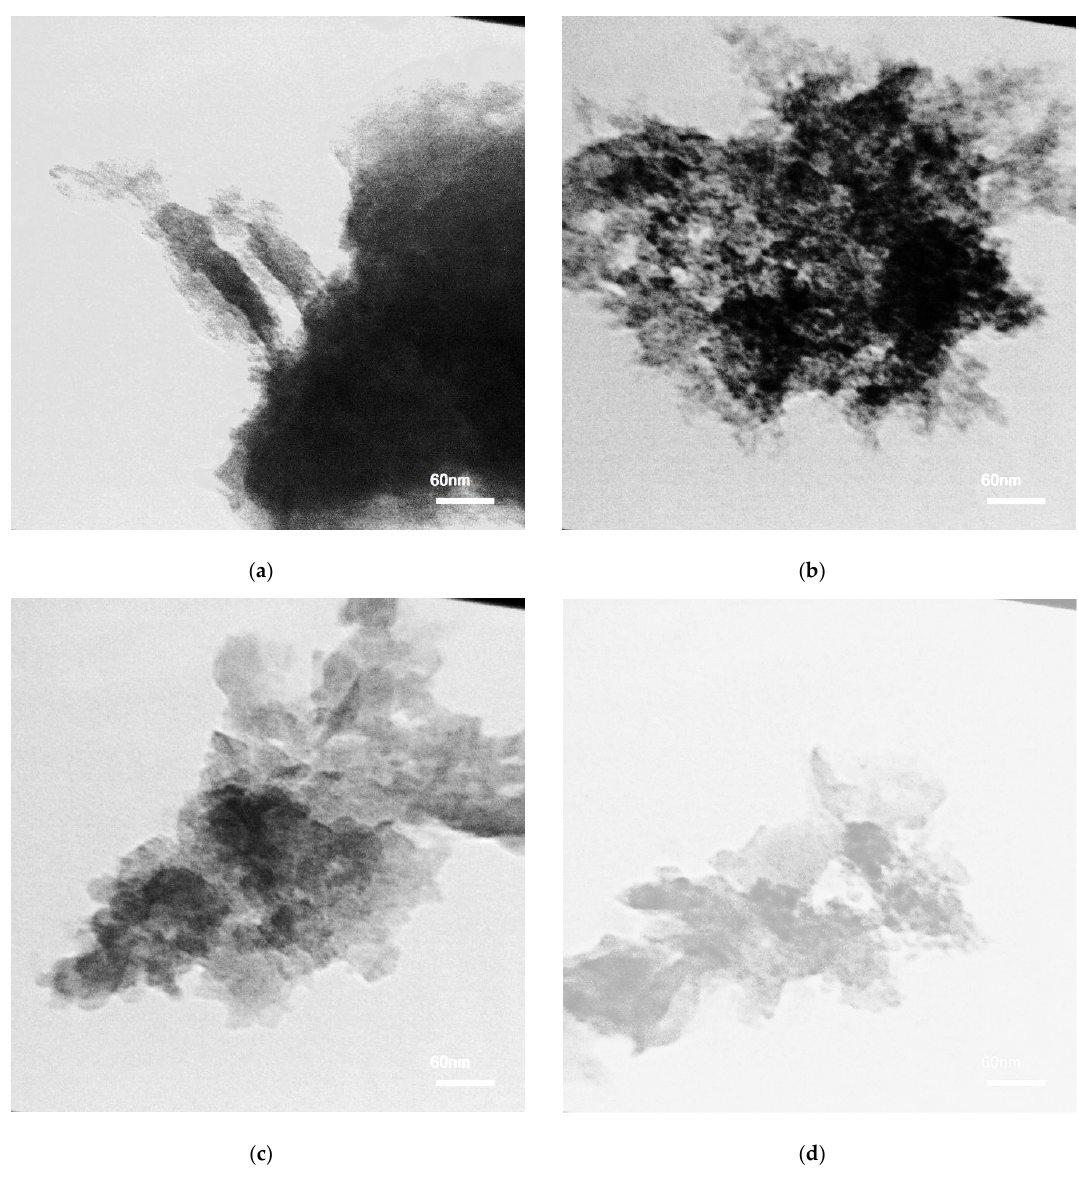
Figure 4. Transmission electron microscopy (TEM) images of ( a ) MoS 2 powder, few-layered MoS 2 nanosheets after ( b ) 40 mJ; ( c ) 60 mJ; and ( d ) 80 mJ laser energy (the scale for all images is 60 nm).